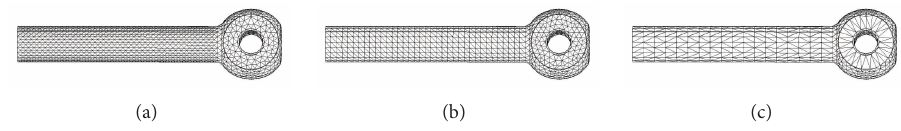
Figure 14: Three different implant models. (a) Mesh size 1.0. (b) Size 1.5. (c) Size 2.0.